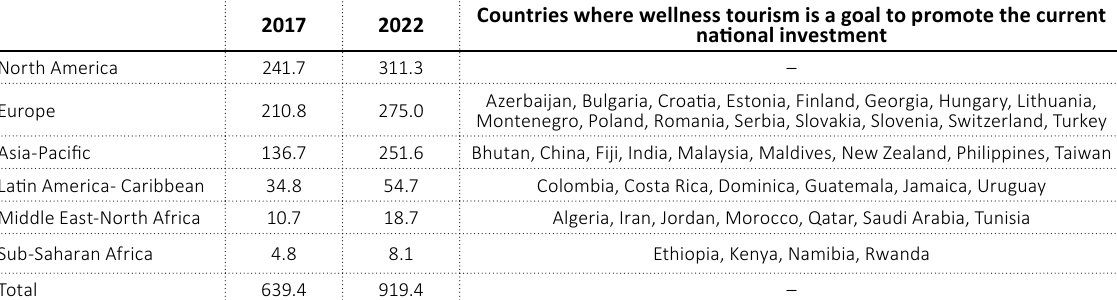
Table 2. Wellness tourism expenditure, USD bln, 2017 and forecast 2022